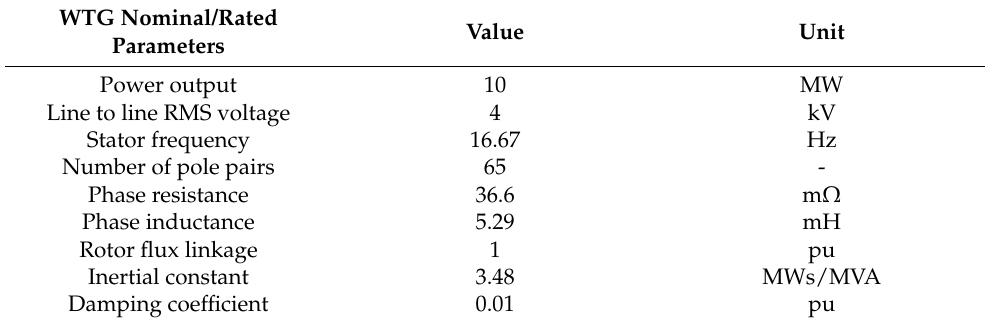
Table 1. WTG parameters.